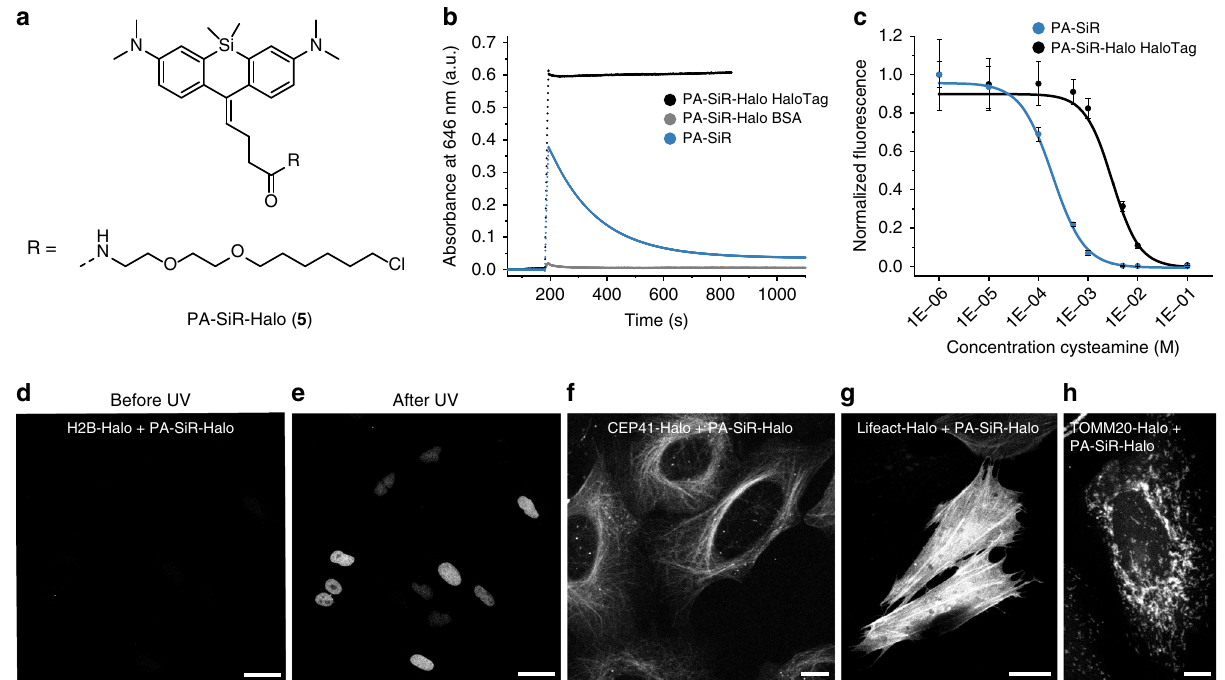
Fig. 2 PA-SiR-Halo and the in fl uence of HaloTag on its equilibrium system. a Chemical structure of PA-SiR-Halo ( 5 ). b Absorbance measurements at 646 nm over time for PA-SiR and PA-SiR-Halo in PBS (10 μ M ). PA-SiR-Halo was measured with addition of BSA or HaloTag (20 μ M ). c Fluorescence signal after addition of cysteamine (0.001 – 100 m M ) to fully activated PA-SiR or PA-SiR-Halo on HaloTag solutions in equilibrium (1 μ M dye on 2 μ M HaloTag). The effective concentrations at which half maximal fl uorescence intensity was reached (EC 50 values) were determined to be 0.192 ± 0.019 m M for PA-SiR and 3.1 ± 0.5 m M for PA-SiR-Halo (mean ± 95% con fi dence interval, both N = 24 samples), error bars correspond to 95% con fi dence intervals. Source data are provided as a Source Data fi le. d , e Maximum projection of a z-stack of U-2 OS cells stably expressing H2B-Halo (nucleus) stained with PA-SiR-Halo (0.5 μ M for 2 h) before d and after UV irradiation e Scale bar, 40 μ m. f – h Confocal images of several HaloTag fusion proteins stained with PA-SiR-Halo (0.5 μ M for 1.5 h): f microtubules (CEP41-Halo). Scale bar, 10 μ m. g F-actin (LifeAct-Halo). Scale bar, 20 μ m. h the outer mitochondrial membrane (TOMM20-Halo). Scale bar, 10 μ